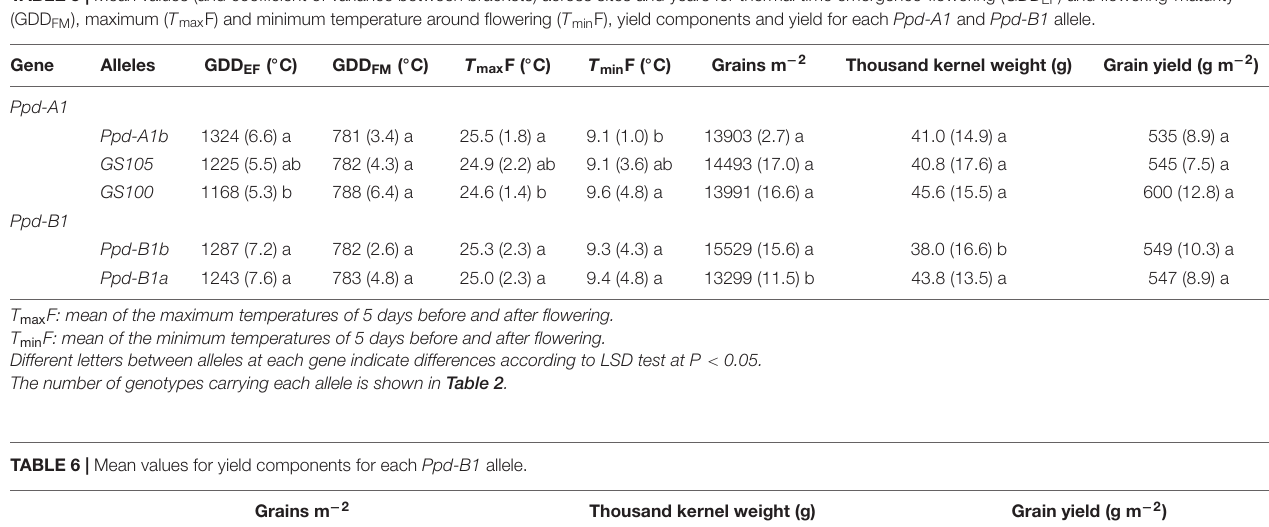
TABLE 5 | Mean values (and coefficient of variance between brackets) across sites and years for thermal time emergence-flowering (GDD EF ) and flowering-maturity (GDD FM ), maximum ( T max F) and minimum temperature around flowering ( T min F), yield components and yield for each Ppd-A1 and Ppd-B1 allele. Gene Alleles